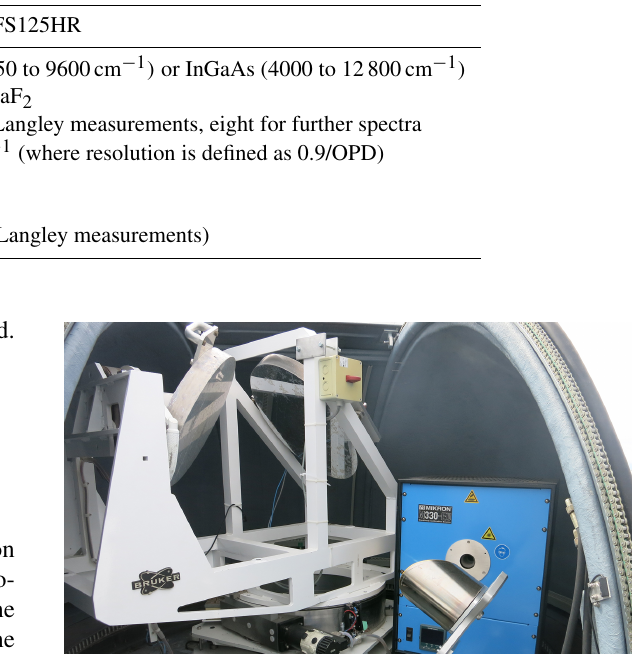
Table 1. Instrumental specifications and settings chosen for the solar FTIR spectra acquisition.